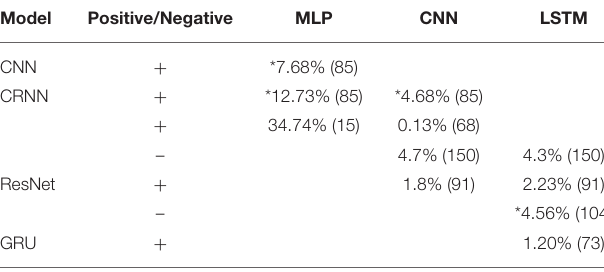
TABLE 11 | Comparison of the methods that were reported in the articles.